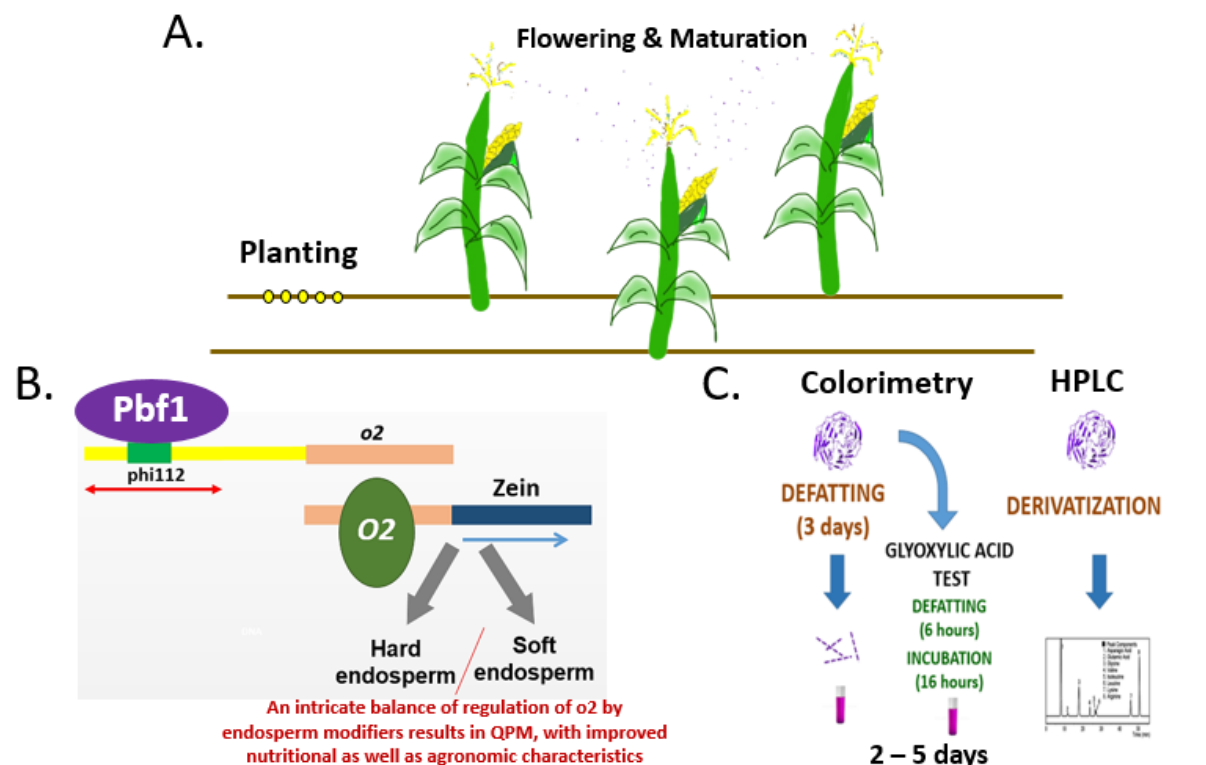
Figure 5. Schematic representation of the key stages and concerns in protein quality in maize. ( A ). Both the planting of authenticated seeds and maintenance of appropriate distance are necessary to ensure high protein quality in maize. ( B ). The authenticity of the planting material can be verified through the use of the dominant marker phi112 in a multiplex format for unambiguity. Pbf1 appears to master-regulate the high protein quality phenotype. ( C ). Analysis of the produced grain through available methods.